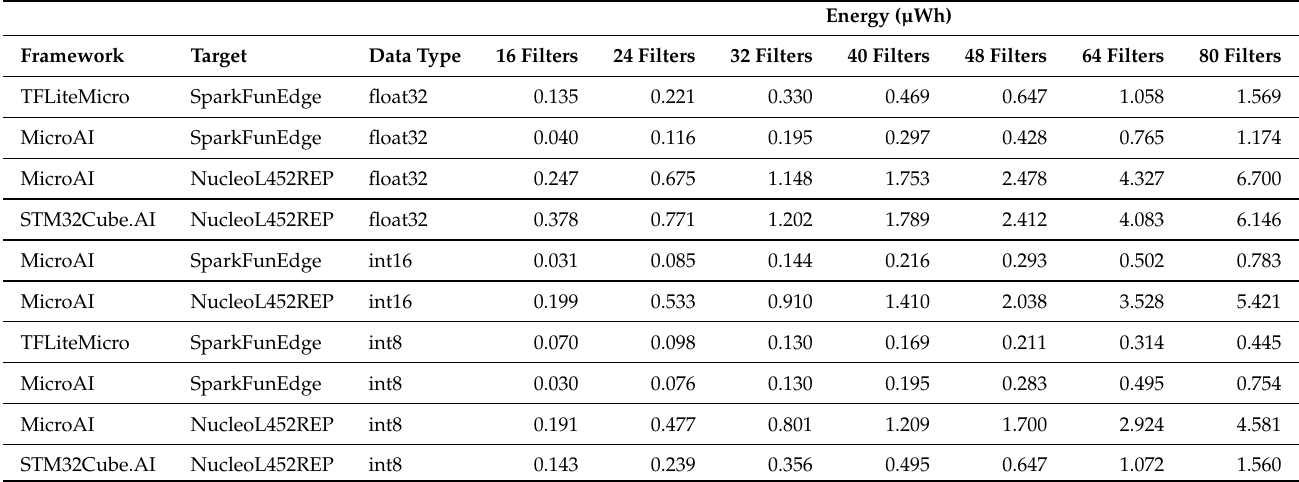
Table A5. Energy consumption for 1 input vs. filters for TFLite Micro, STM32Cube.AI and MicroAI.